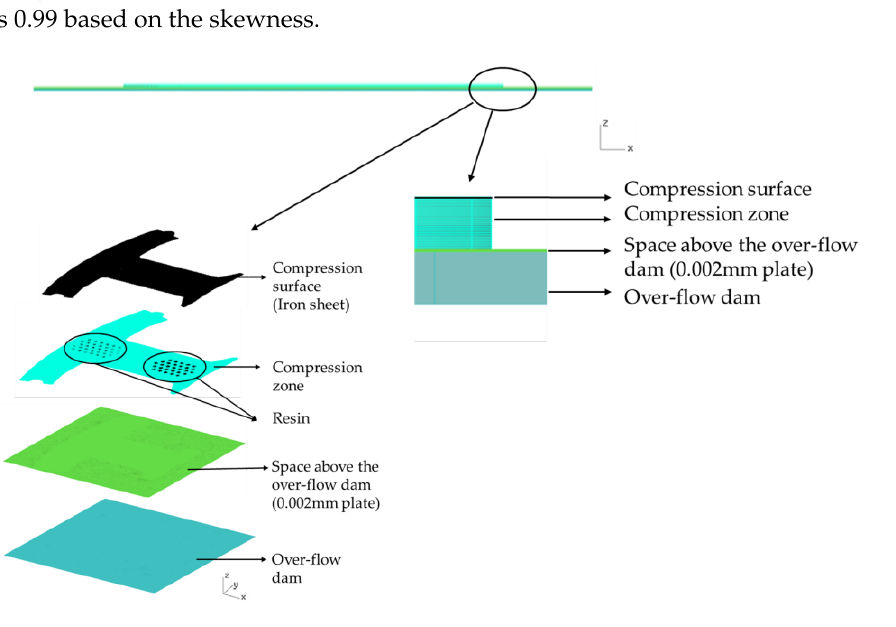
Figure 7. Mesh model used in the filling process. 183